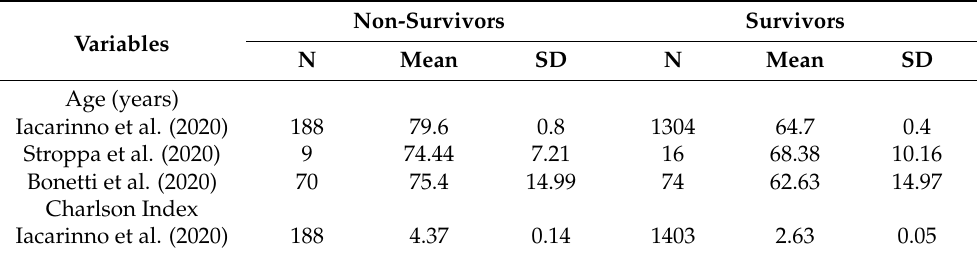
Table 2. Descriptive analysis of quantitative variables, according to groups of survivors and non- survivors.